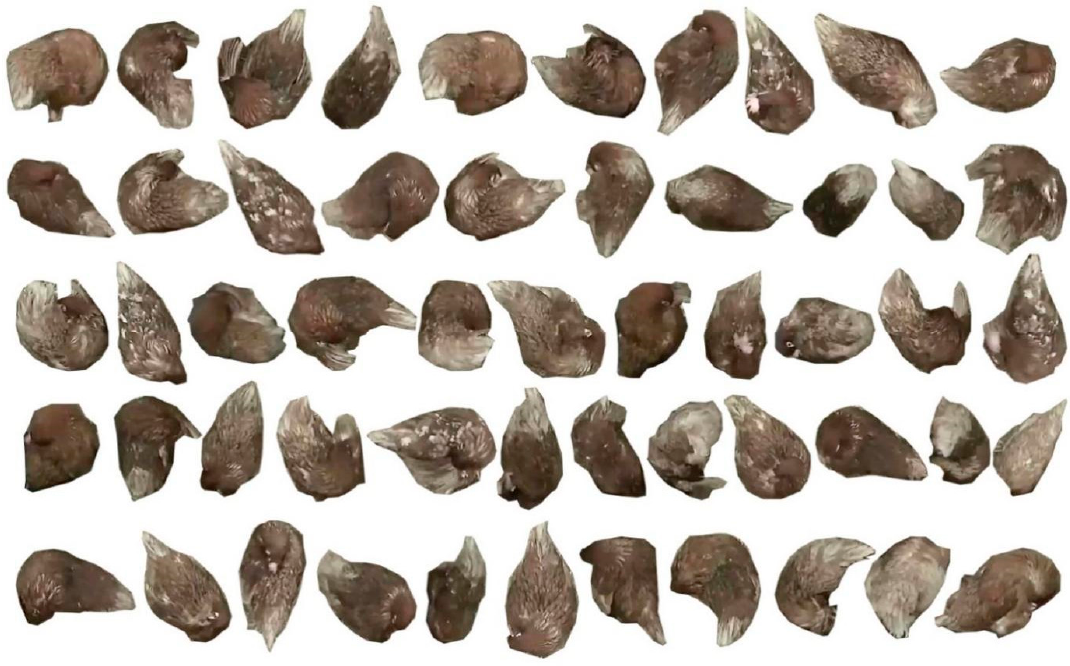
Figure 1. Sample pictures of preening hens. The preening birds were manually cropped from original images.